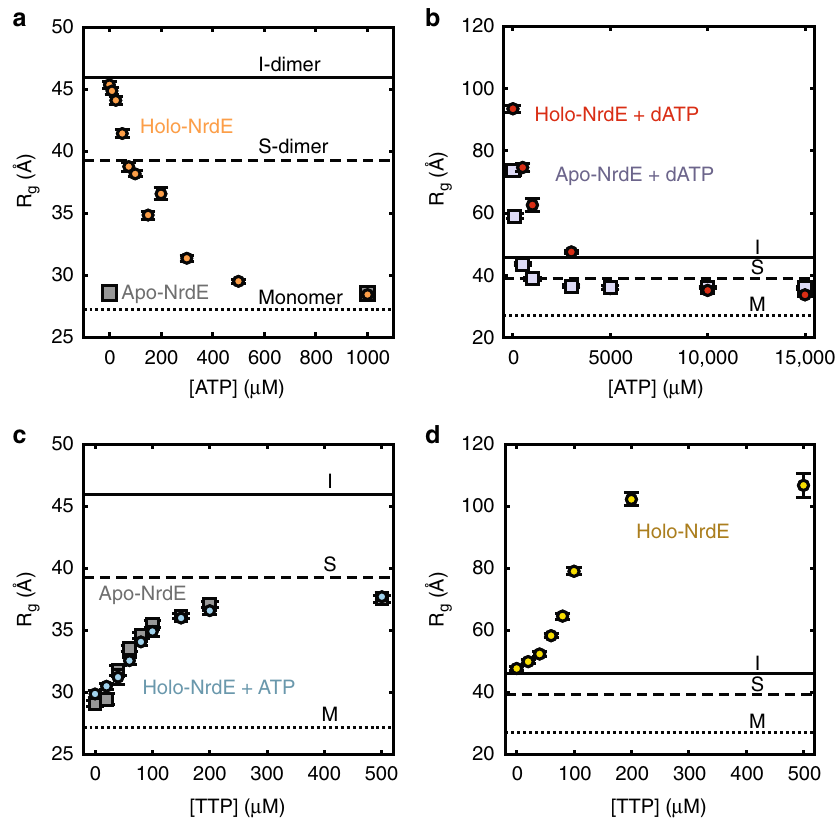
Fig. 3 SAXS reveals a complex interplay of four distinct oligomerization states of NrdE. In all plots, the theoretical R g values of the I-dimer (46 Å, solid line), S-dimer (39 Å, dashed line), and monomer (27 Å, dotted line) are shown for comparison. a Titration of 0 – 1 mM ATP to 4 μ M holo-NrdE (orange circles) leads to a reduction in R g , consistent with the dissociation of I-dimer to monomer and con fi rmed by SEC – SAXS (Supplementary Fig. 7a). In contrast, the R g of 4 μ M apo-NrdE (gray squares) remains constant up to 1 mM ATP. b Titration of 0 – 15 mM ATP to 4 μ M holo-NrdE (red circles) or apo-NrdE (lavender squares) in the presence of 50 μ M dATP leads to a decrease in R g that converges to a value near the theoretical value of an S-dimer. c Titration of 0 – 500 μ M TTP to 4 μ M apo-NrdE (gray squares) leads to an increase in R g that is suggestive of a monomer to S-dimer transition. A similar transition is observed with the addition of TTP to 4 μ M holo-NrdE in the presence of 3 mM ATP (blue circles) and was further con fi rmed by SEC – SAXS (Supplementary Fig. 7b). d Titration of 0 – 500 μ M TTP to 4 μ M holo-NrdE in the absence of ATP leads to an increase in R g and a fi nal pro fi le that resembles the